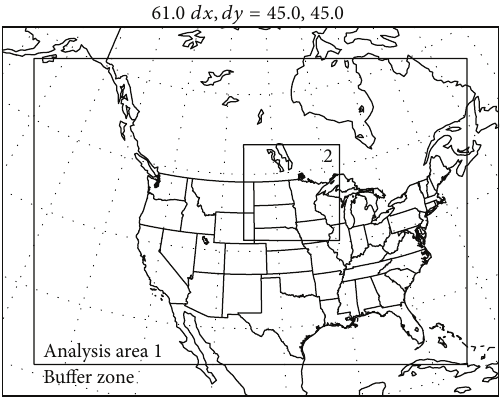
Figure 1: Model domain area with buffer zone and analysis areas 1 and 2 used for this